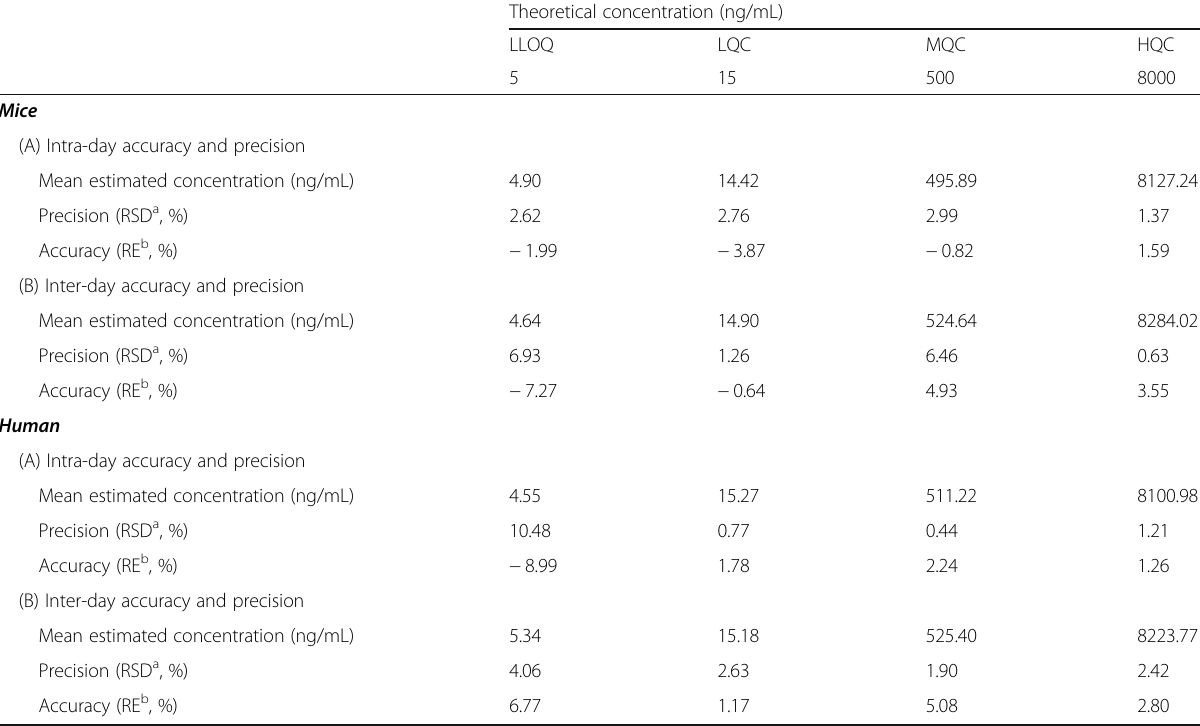
Table 1 Reproducibility and accuracy for larotrectinib in mice and human plasma ( n = 5) Theoretical concentration (ng/mL)